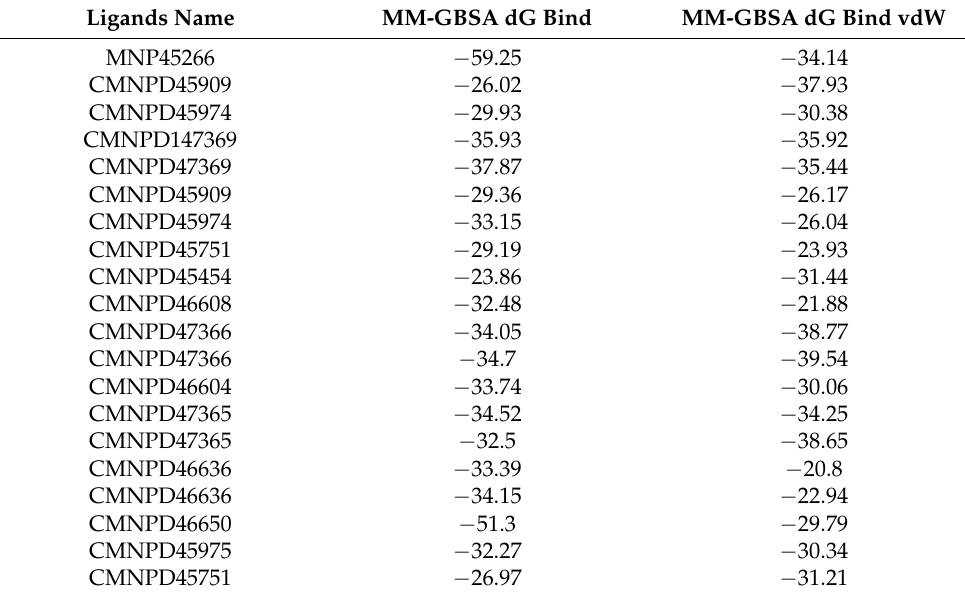
Table 4. MM-GBSA binding energy of the first 20 compounds with